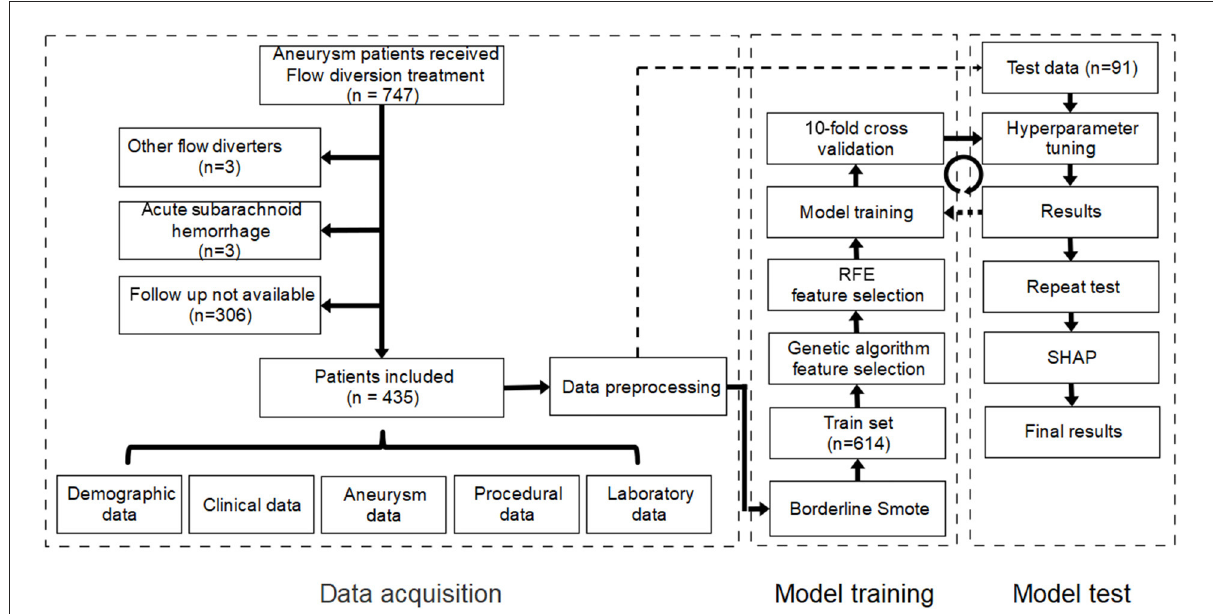
FIGURE1 Study flow chart of patient selection and establishment of the machine learning model. RFE, recursive feature elimination; SHAP, Shapley additive